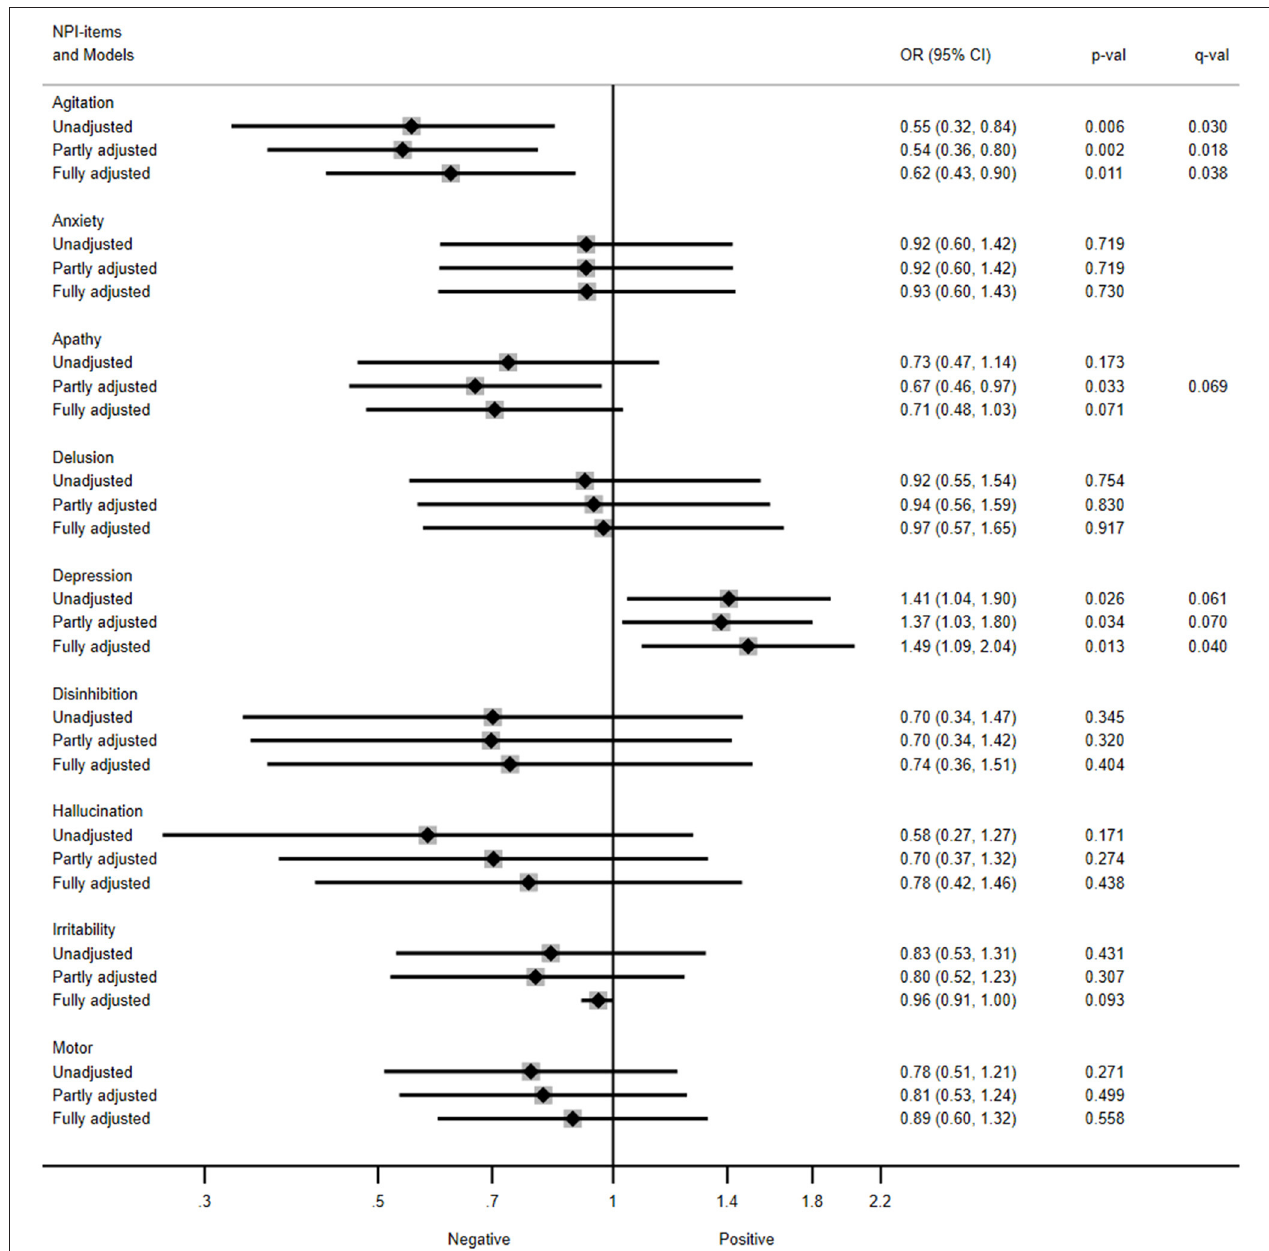
FIGURE 4 | Association between amygdala volume and trajectories of neuropsychiatric symptoms in the total sample. NPI, Neuropsychiatric inventory; OR, Odds ratios; CI, Confidence interval. Unadjusted model included amygdala and time as covariates; partly adjusted model also included age, gender, and diagnosis as covariates; fully adjusted model included MMSE score over 5 years as covariate. The OR (95% CI) refers to the risk of being in a one-level higher group on each of the ordinal NPI items (i.e., presenting mild symptoms, or developing a clinically relevant symptom). Multiple testing-corrected p -values ( q -values) > 0.1 are